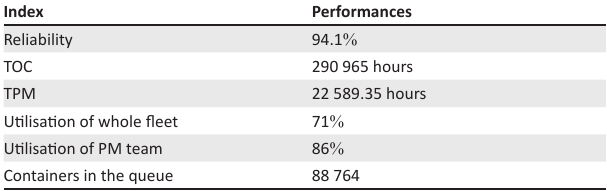
TABLE 12: Outcomes for increasing proportion of new lifting work